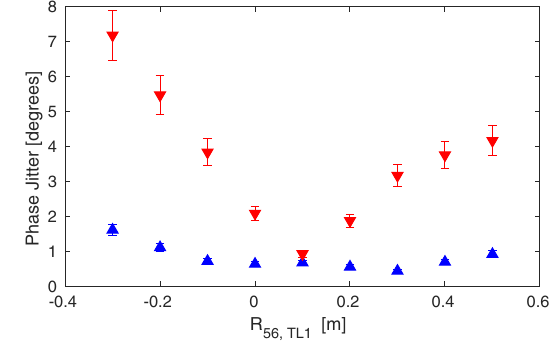
FIG. 3. Measured downstream (red) and upstream (blue) phase jitter vs TL1 R 56 value. Error bars show the statistical standard error on the measured jitter values.